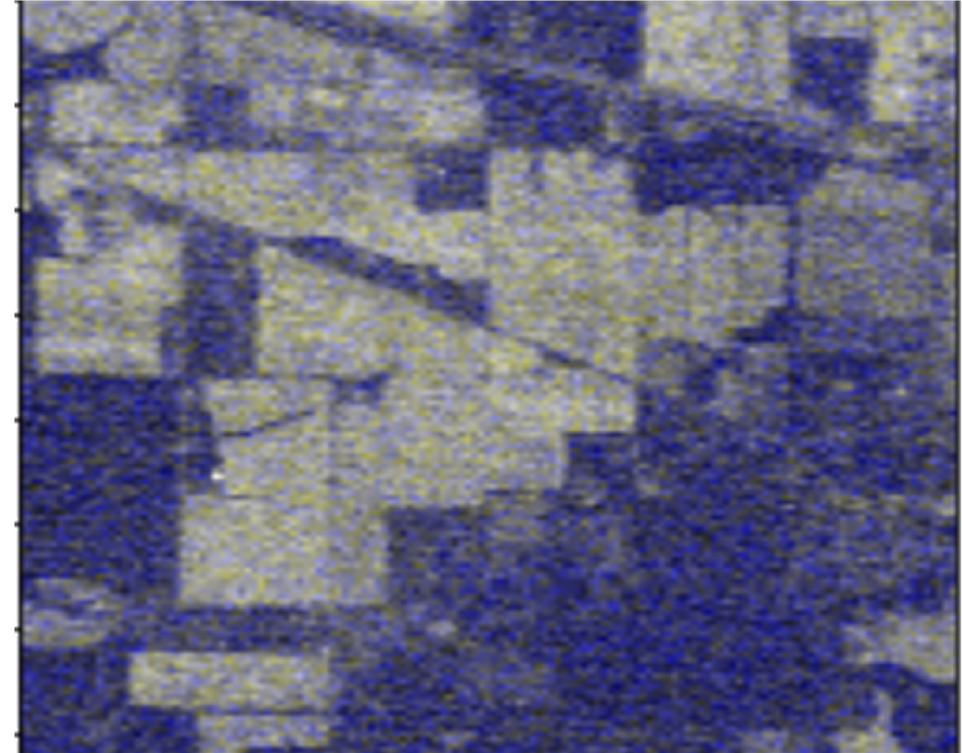
Figure 7. Image segmentation for Indian Pines Dataset.